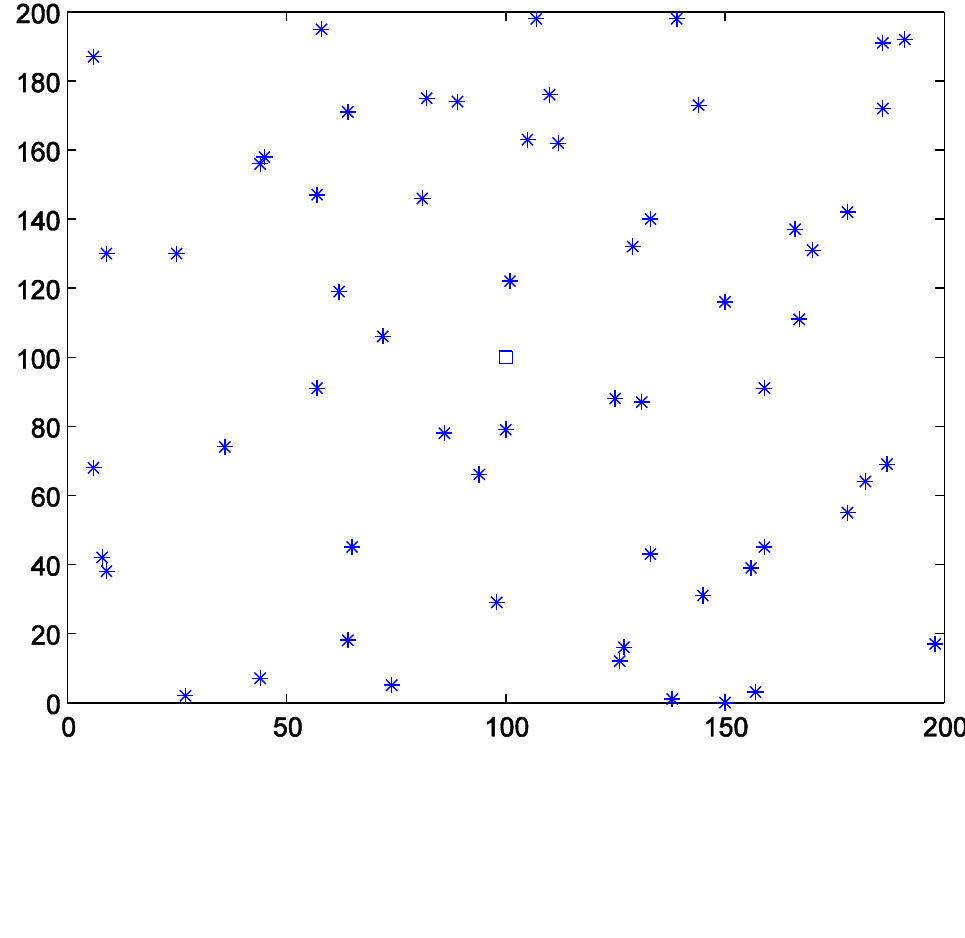
Figure 3. Locations of MAPs (labeled by asterisks) and the LCDH (labeled by the